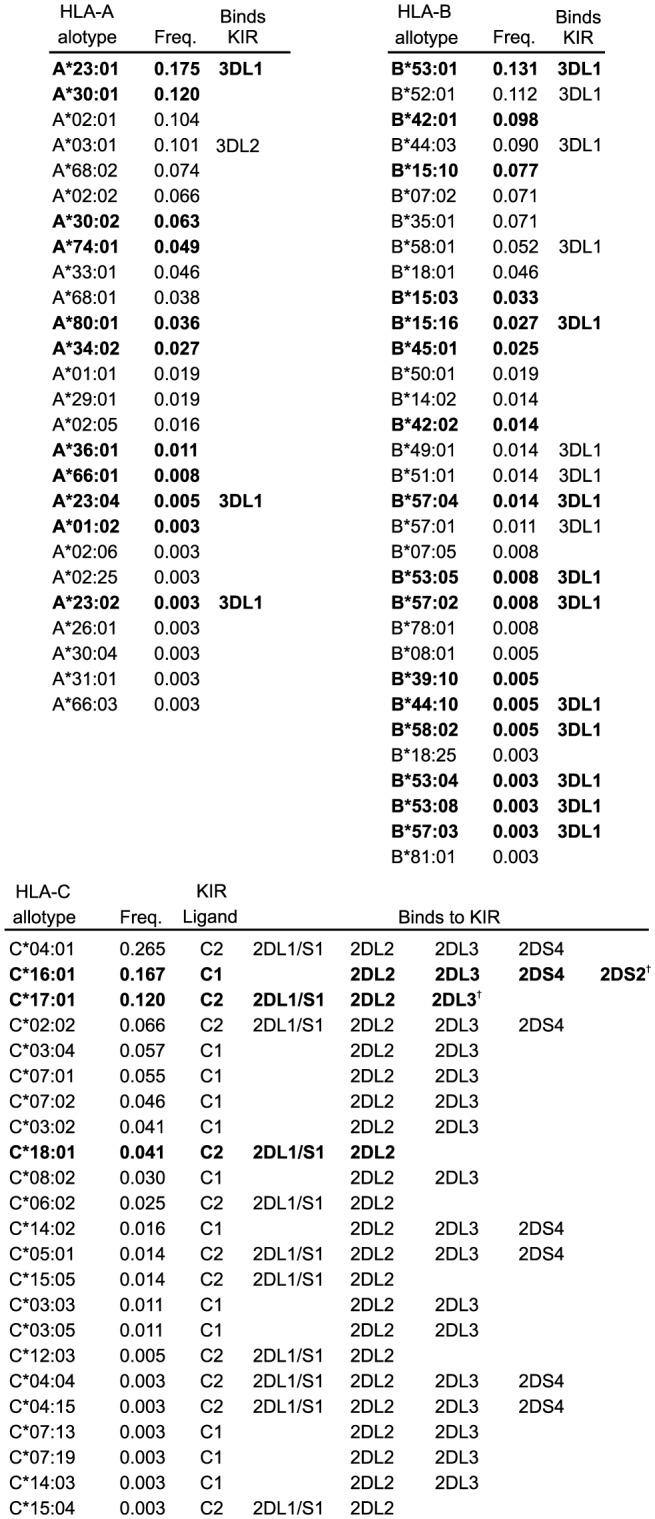

HLA-A, -B and -C allele frequencies in the Ga-Adangbe.Shown are the HLA-A, -B and -C allotypes (left) identified in the Ga-Adangbe study population (2N = 366), their frequencies (centre) and the KIR they interact with (right); † – from [113] and Hilton et al. (unpublished). Characteristic alleles of sub-Saharan African populations [13], [74] are shown in bold. By frequency, approximately half of the HLA-A and -B and one third of the HLA-C alleles are specific to sub-Saharan Africans (twelve HLA-A alleles; combined frequency 50.3%: fourteen HLA-B alleles; and 45.4%: three HLA-C alleles; 32.8%).